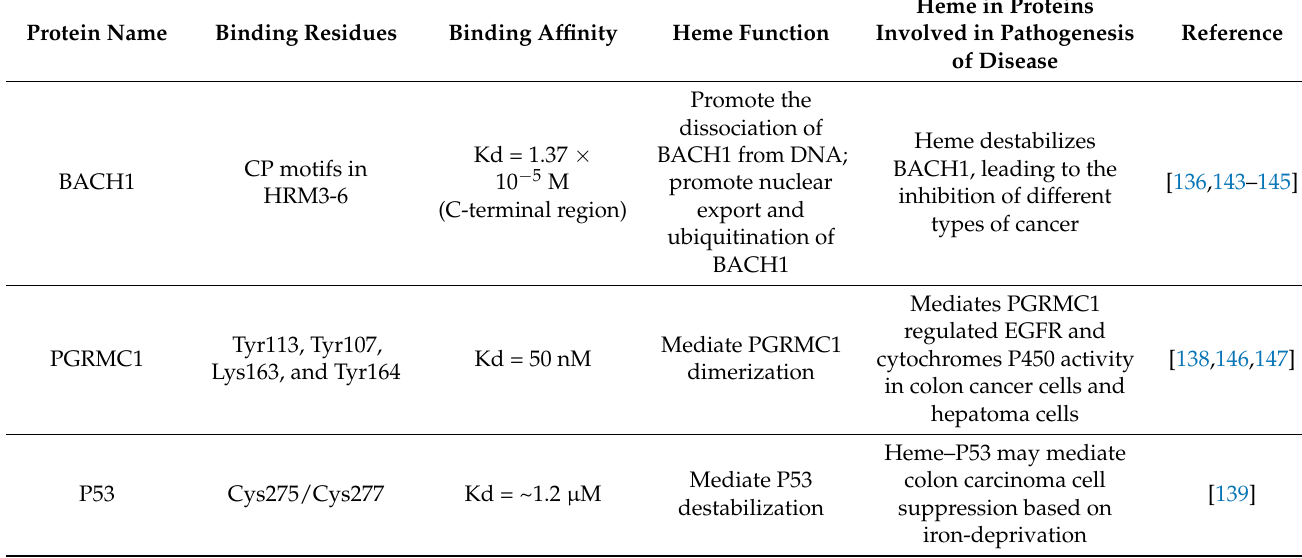
Table 1. Heme regulated multifunctional signal transducers and regulators involved in disease diagnoses and treatments.